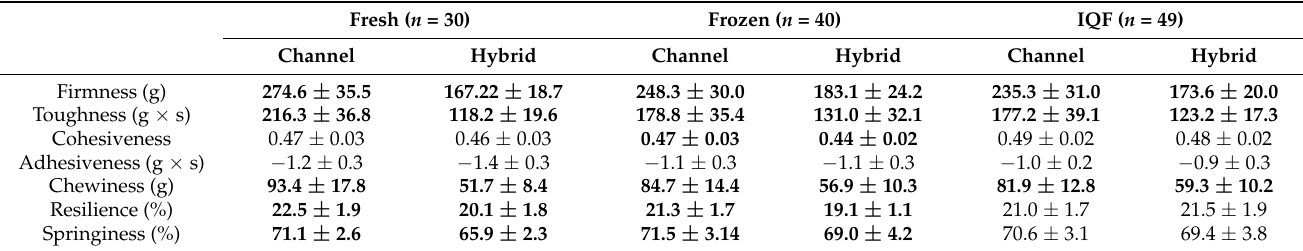
Table 3. Instrumental textural differences 1 between cooked channel and hybrid catfish fillets according to cold-storage type. Values expressed as means ± standard deviations.